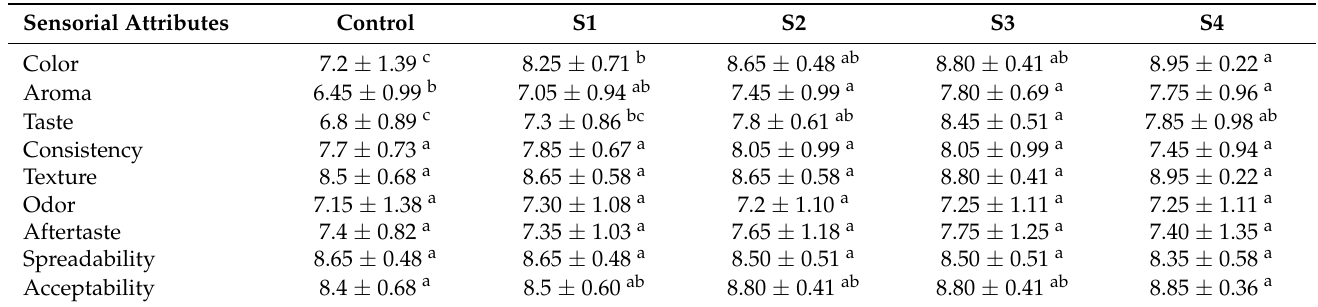
Table 7. The consumer acceptability scores of mayonnaise enriched with